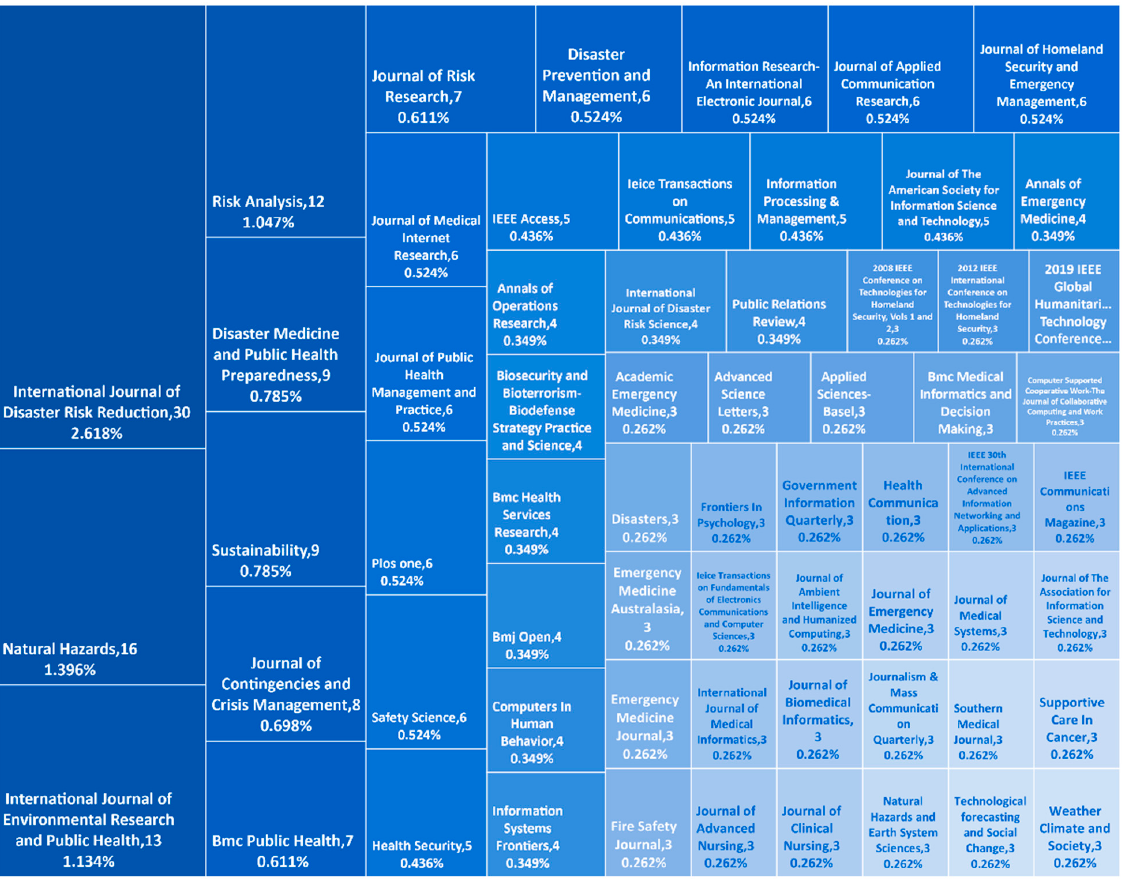
Table 1. Journal distribution (TOP 10).